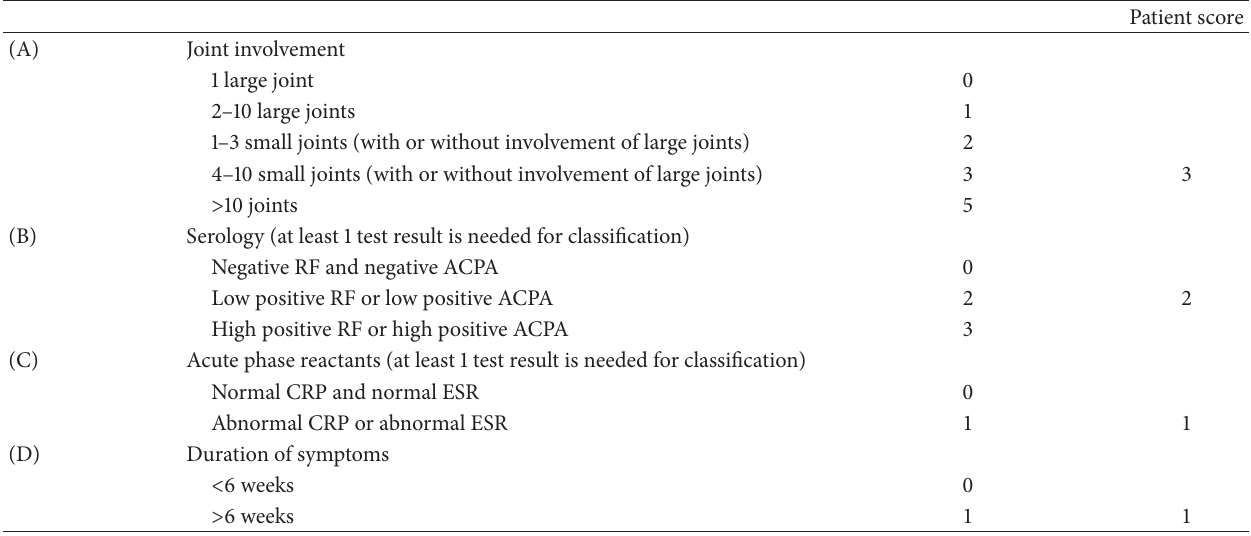
Table 1: Showing scoring of our patient based on the 2010 American College Of Rheumatology classification criteria of rheumatoid arthritis